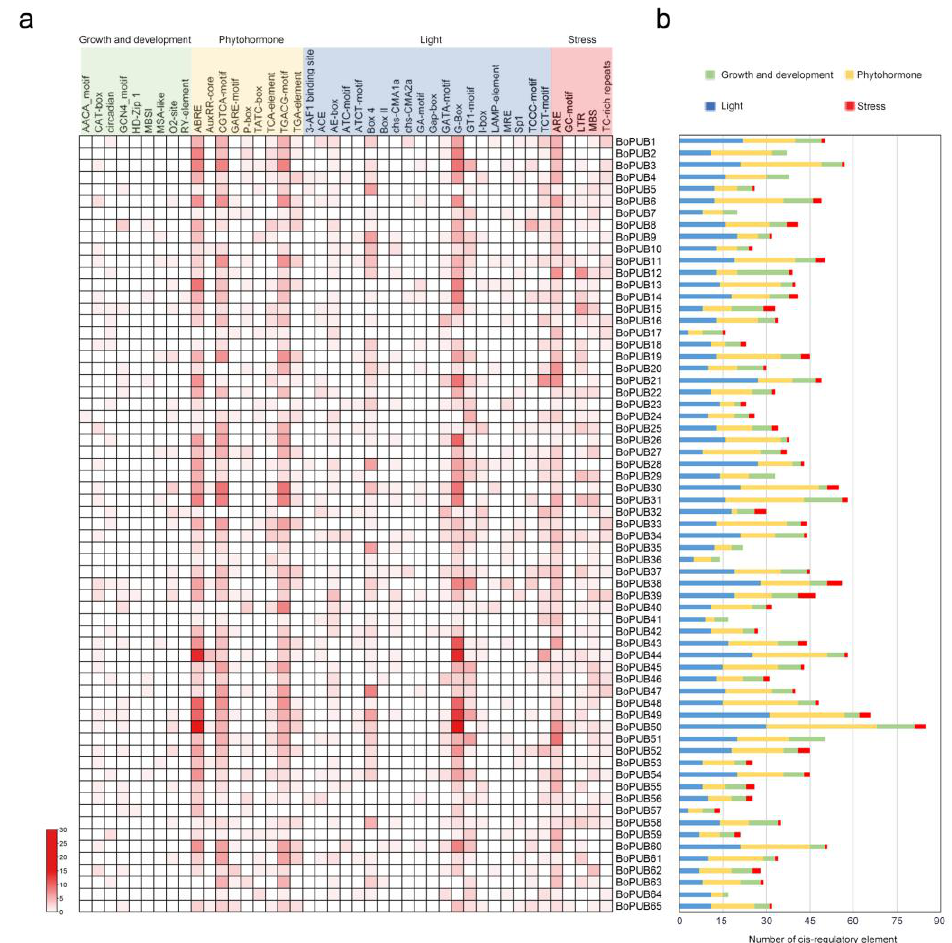
Figure 5. Analysis of cis-regulatory elements in the promoter regions of BoPUB genes. ( a ) Heatmap showing the number of individual cis-regulatory elements in the promoter of each BoPUB gene. Each row and column in the red grid indicate a single gene and cis-regulatory element, respectively, and their names are shown. Forty-three cis-regulatory elements are clustered into four categories based on corresponding biological processes, including growth and development process (growth and development), phytohormone response (phytohormone), light response (light), and stress response (stress). Detailed information on these cis-regulatory elements is listed in Table S6. ( b ) Stacked histogram showing the composition of four types of cis-regulatory elements in the promoter of each BoPUB gene. The number of cis-regulatory elements is shown on the x -axis, and gene names are shown on the y -axis. Green bars represent the growth and development process (growth and development); yellow bars represent the phytohormone response (phytohormone); blue bars represent the light response (light); and red bars represent the stress response (stress).